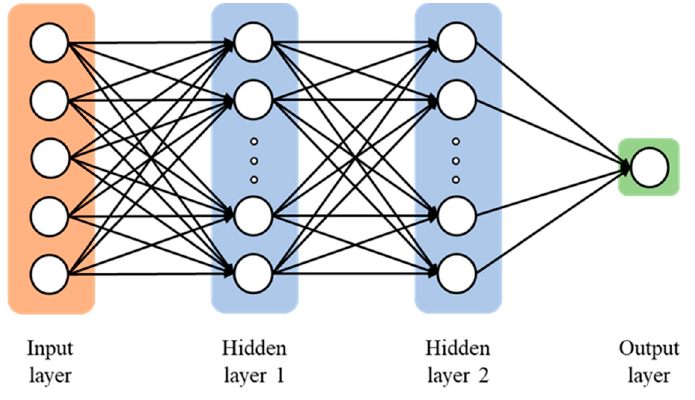
Figure 1. The construction of the artificial neural network (ANN) [20].